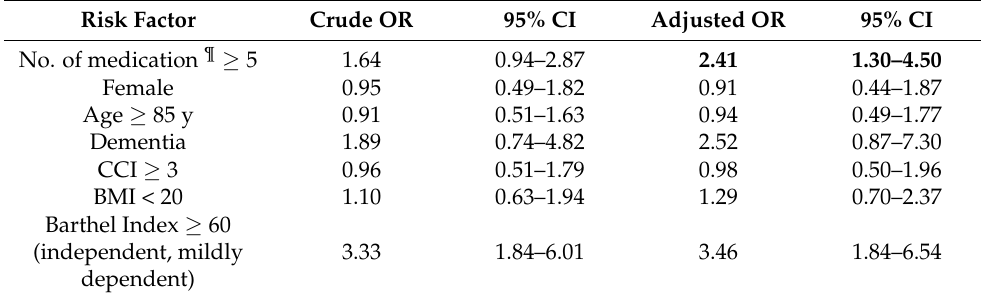
Table 5. Odds ratios of injury occurrence after falls based on logistic regression